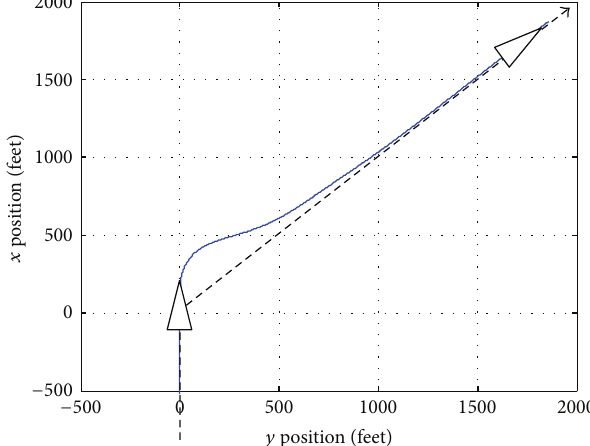
Figure 9: Lateral deviation step response (correct order reduction).